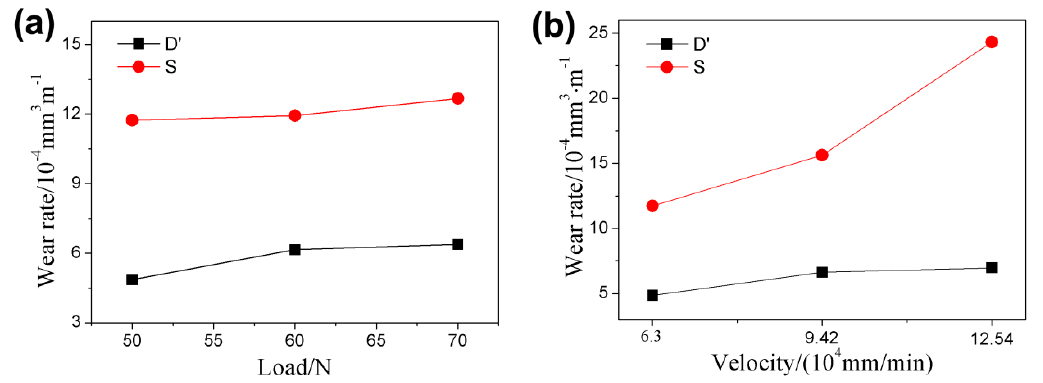
Figure 11. Wear rates of the ductile iron and carbon steel wheels with respect to ( a ) the normal load at 6.3 × 10 4 mm/min and ( b ) the sliding velocity under a normal load of 50 N.